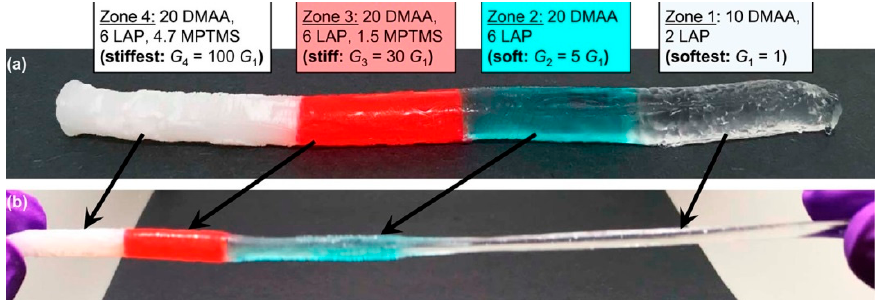
Figure 1. Variations of the soft − sti ff hybrids: ( a , b ) multizone cylinders. ( a ) The gel has four zones, with zone 1 on the far right being the softest, with a shear modulus G1 ≈ 1 kPa and zone 4 on the far left having a modulus ~100 G 1 . Between these, there are two more zones, each colored with a di ff erent dye and having intermediate moduli, as indicated. Zones 1 and 2 are prepared without methacrylated silane (MPTMS) and are transparent, whereas zones 3 and 4 have MPTMS and are opaque. ( b ) The cylinder is stretched to show that zones 3 and 4 are negligibly extended, zone 2 is extended as it, and zone 1 is extended a lot. Reprinted from [5] with